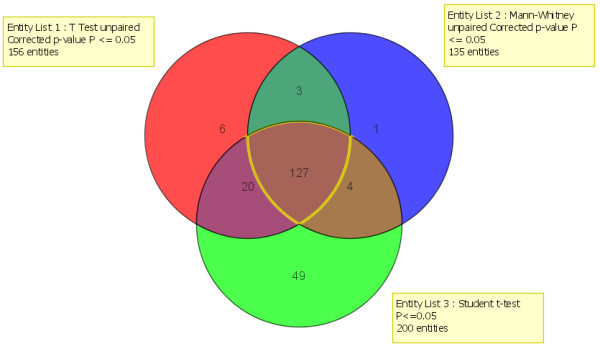
MicroRNAs that separate tumour from normal. The intersection of three separate statistical tests yielded 127 microRNA that more significantly differentiate tumour from normal samples. The tests included an unpaired T-test (p < 0.05) with a Benjamini Hochberg FDR multiple testing correction and an unpaired Mann-Whitney test (p < 0.05) with a Benjamini Hochberg FDR multiple testing correction from within GeneSpring GX 11.0, and a Student's t-test (p < 0.05). Data for these 127 microRNA were subsequently used for further clustering of the samples and SNR analysis to uncover the top microRNA which differentiate tumour and normal samples.